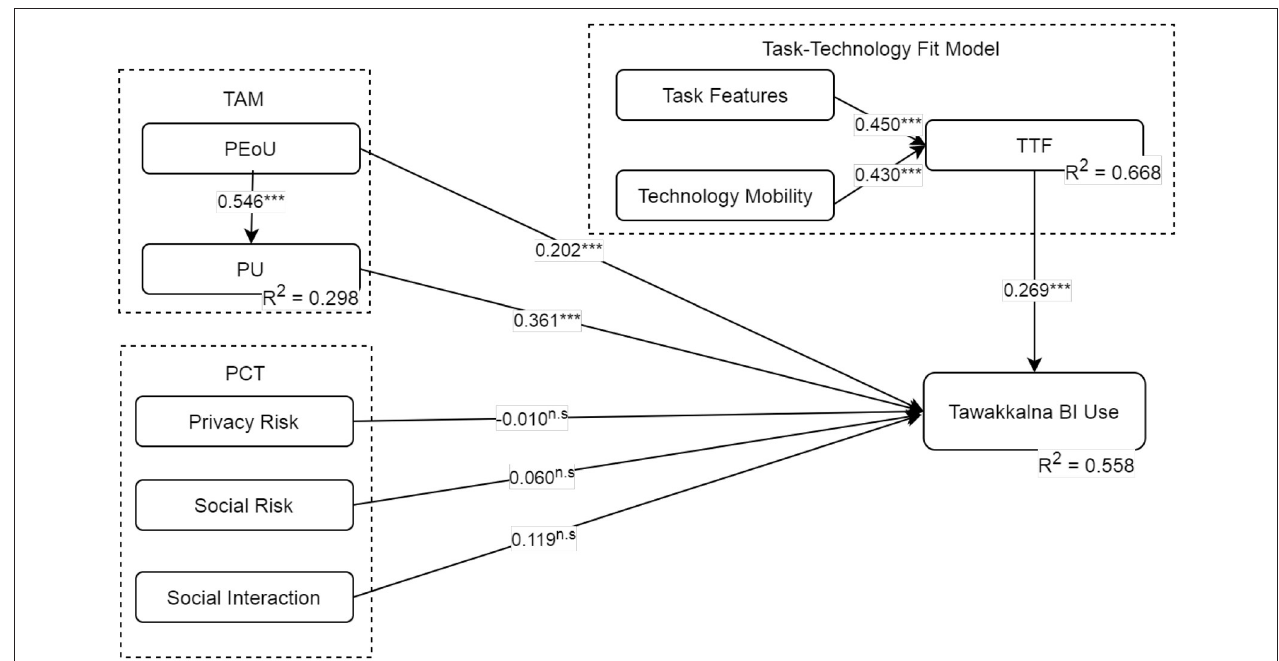
FIGURE 3 | Test results of the structural model. n.s., non-significant; * p < 0.05; ** p < 0.01; *** p < 0.001.